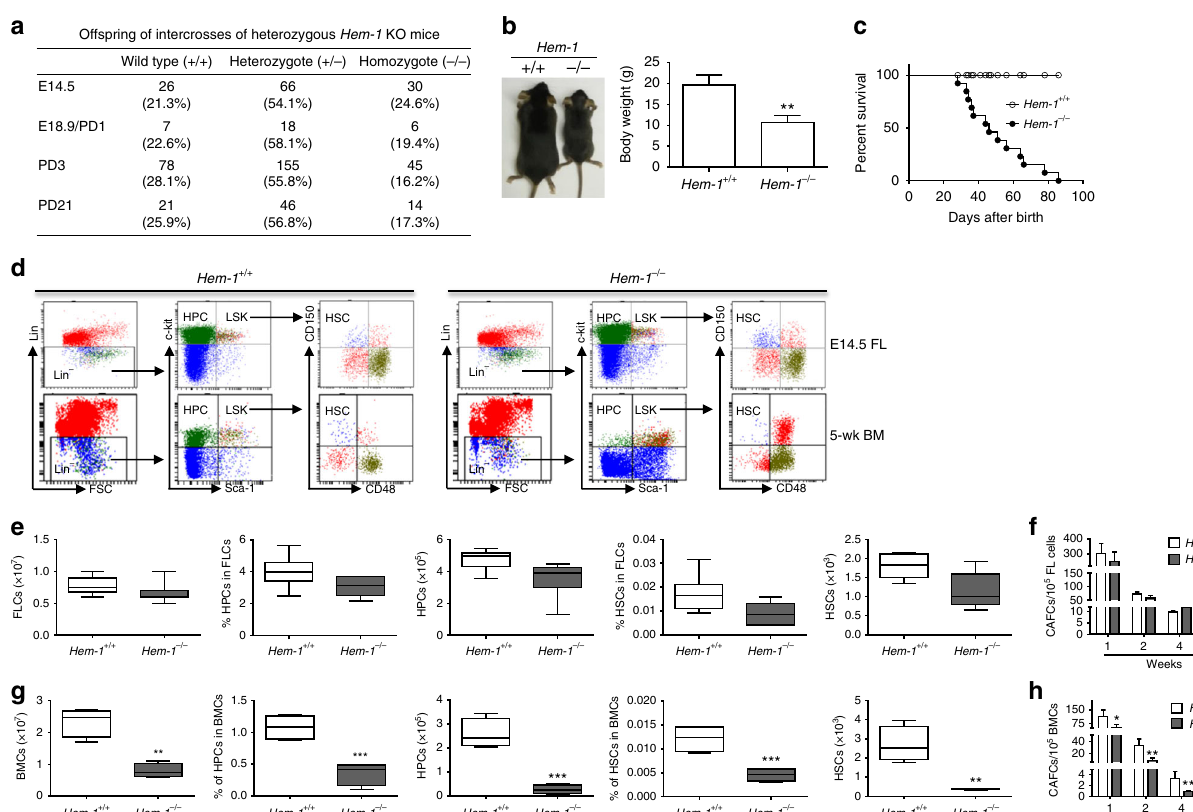
Fig. 1 Hem-1 − / − mice exhibit decreased HPCs and HSCs, and die prematurely. a Genetic characterization of Hem-1 + / − offspring, demonstrating that Hem-1 − / − mice are born with appropriate Mendelian frequency. b Hem-1 − / − mice have growth retardation compared to littermate Hem-1 + / + mice ( Hem-1 + / + mice, n = 6; Hem-1 − / − mice, n = 8, ** p < 0.01, Student ’ s t test). c Hem-1 − / − mice die an average of 6 weeks after birth ( n = 13, p < 0.001, log- rank test). d Flow cytometric analytic schematic of hematopoietic stem and progenitor cells in Hem-1 − / − and littermate Hem-1 + / + mice. (FSC: forward scattered light, Lin − : CD3e − /CD11b − /CD45R − /B220 − /Ter-119 − /Gr-1 − , LSK: Lin − /Sca-1 + /c-Kit + , HPC: Lin − /Sca-1 − /c-Kit + , HSC: LSK/CD150 + /CD48 − ). e E14.5 fetal liver hematopoietic stem and progenitor cells subsets are not different between Hem-1 − / − and littermate Hem-1 + / + mice ( n = 10). f E14.5 FL cobblestone area-forming cells (CAFCs) are not different between Hem-1 − / − and Hem-1 + / + mice ( n = 3). g Five-week Hem-1 − / − BM exhibits decreased hematopoietic stem and progenitor cell subsets ( n = 5, ** p < 0.01, *** p < 0.001, Student ’ s t test). h Five-week Hem-1 − / − BM CAFCs are reduced compared to littermate Hem-1 + / + mice ( n = 3, * p < 0.05, ** p < 0.01, Poisson statistics). Error bars represent the mean ± SD − / − + / + cells were half the numbers of their Hem-1 (Supplementary Fig. 4). In contrast, neutrophils from Hem-1 counterparts mice are defective in fMLP-stimulated F-actin polymerization, (Fig. 3c). Next, we assessed Hem-1 − / − E14.5 FL LSK migration to actin capping and migration, and adhesion to fi bronectin as the the BM osteoblast niche 32 . There were equivalent numbers of 1,1 ′ - cells from Hem-1 mutant mice reported previously (Supple- dioctadecyl-3,3,3 ′ ,3 ′ -tetramethylindodicarbocyanine perchlorate mentary Fig. 5) 21 . Furthermore, we found that inhibition of (DiD)-labeled Hem-1 − / − E14.5 CD45.2 FL LSK within the CDC42 with a speci fi c inhibitor, CASIN, suppressed both E14.5 osteoblastic niche 16 h after injection into non-ablated CD45.1 Hem-1 + / + and Hem-1 − / − FL LSK cell adhesion and migration col2-3-EGFP reporter mice as littermate Hem-1 + / + equivalent in vitro (Fig. 3b). These fi ndings suggest that unlike neutrophils cells (Fig. 3d). However, 48 h after injection, there were more than and other hematopoietic cells in adult mice, FL HSCs can migrate twice the numbers of Hem1 + / + E14.5 FL LSK within the niche − / − compared to equivalent Hem-1 FL LSK cells (Fig. 3d) 32 , and home to the BM independent of the WAVE complex, per- implying that the Hem-1 − / − FL LSK cells failed to survive and/or haps via the CDC42 Wiskott – Aldrich syndrome protein (WASP) failed to proliferate once arriving in the BM niche. Using three- pathway. This is consistent with the observation that HSCs from dimensional analysis, the distance to the nearest col2-3-EGFP WASP-de fi cient mice had decreased BM homing capability in osteoblast and endosteum was also not signi fi cantly different association with a defect in adhesion to collagen 31 . between Hem-1 + / + and Hem-1 − / − E14.5 FL LSK 16 and 48 h We next assessed whether FL hematopoietic stem/progenitor after the injection (Supplementary Fig. 6), indicating that Hem-1 cells (HSPCs) were able to migrate to the BM in vivo after − / − E14.5 FL LSK can adhere to the osteoblastic niche equally transplantation. 5-(and 6-)-Carboxy fl uorescein succinimidyl ester − / − + / + CD45.2 FL LSK cells homed to the E14.5 FL LSK. Interestingly, both cell types well as Hem-1 (CFSE)-labeled E14.5 Hem-1 adult BM as well as their normal littermate counterparts after they moved closer to the endosteum between the 16 and 48 h time were transplanted into lethally irradiated CD45.1 mice (Fig. 3c) 32 . points. There was no difference in the numbers of Hem-1 − / − E14.5 FL LSK + / + Hem-1 − / − FL HSCs cannot survive in the BM . We then mea- cells. cells in the BM 16 h after injection as equivalent Hem-1 However, 48 h after arrival in the BM, Hem-1 − / − E14.5 FL LSK sured the ability of Hem-1 − / − E14.5 CD45.2 FL LSK cells to NATURE COMMUNICATIONS| (2018) 9:2377 |DOI: